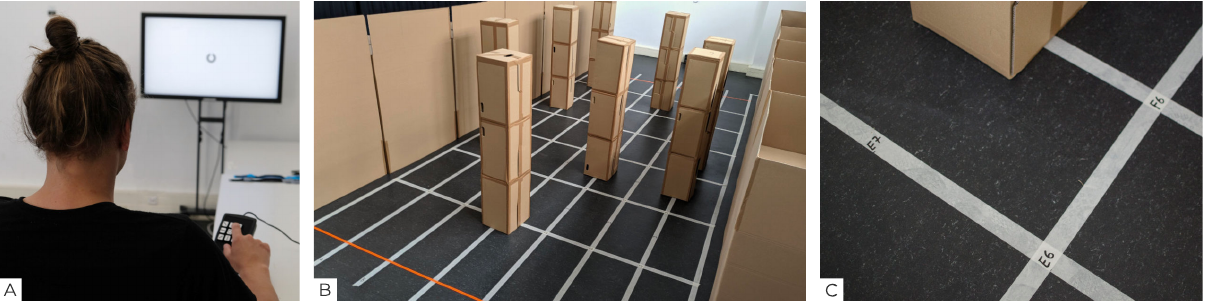
Figure 2. ( A ) Carrying out the “FrACT” Landolt visual acuity test with screen and tactile input device (lower right corner). ( B ) The obstacle course in the study room. ( C ) Close up of the grid system used for quick rebuilding of the